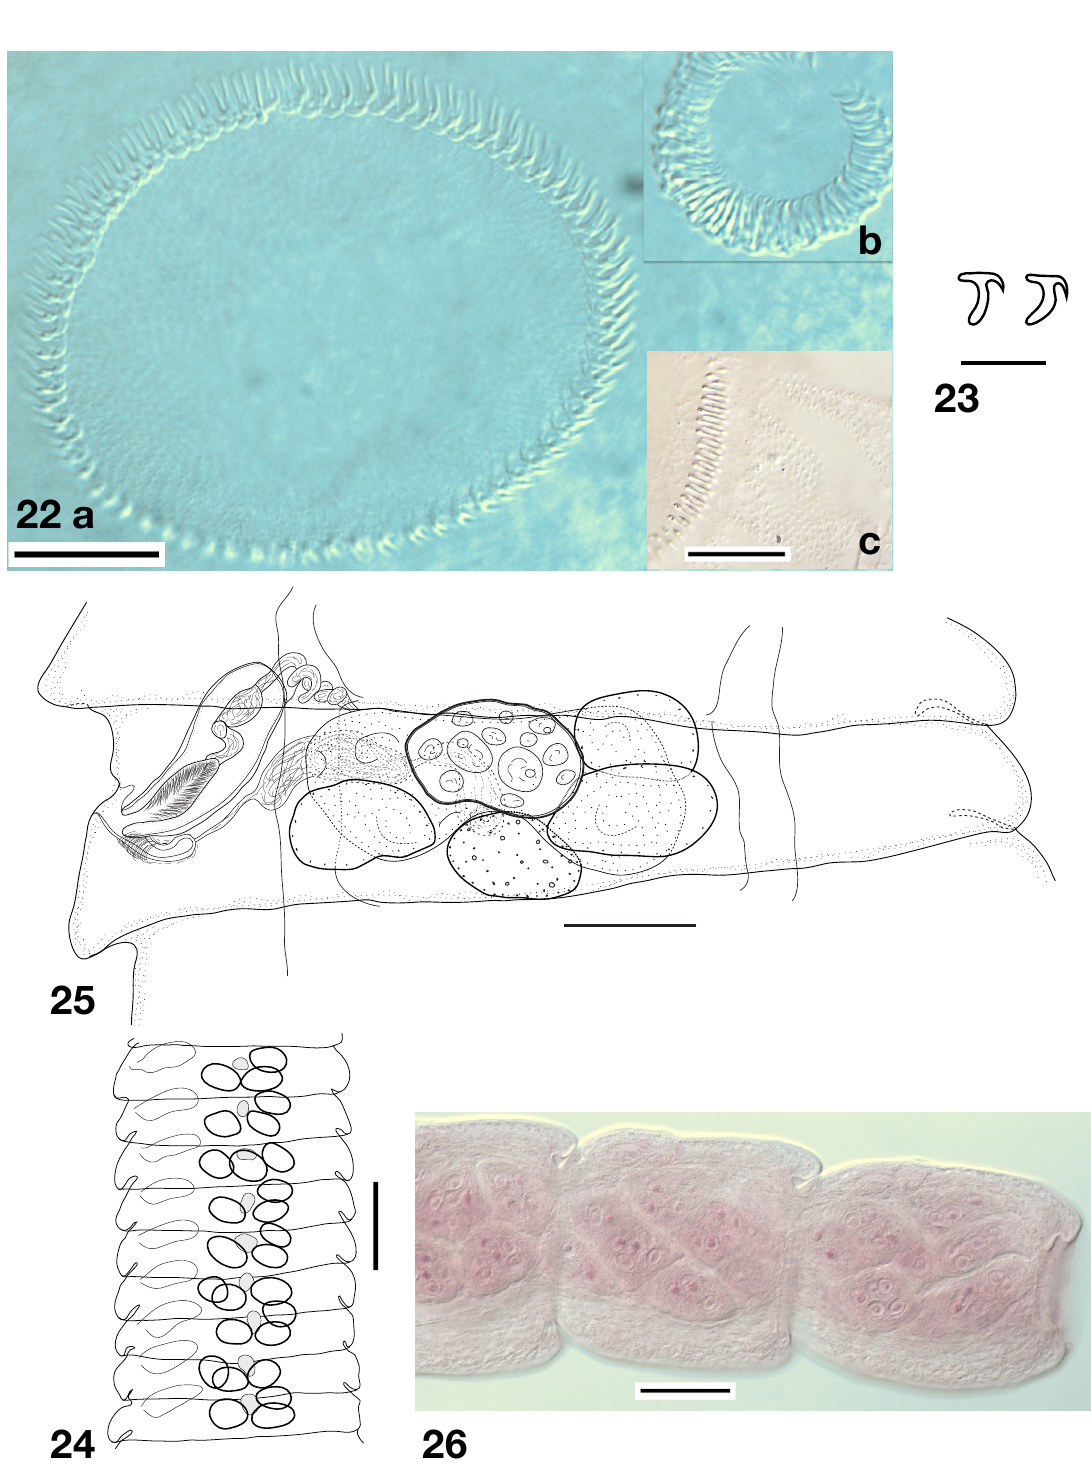
Figs 22-26. Raillietina hymenolepidoides sp. nov. 22 . a) Complete rostellar crown, b) Sucker's hooklets, c) Apical tegument with spiniform microtriches; 23 . Rostellar hooks; 24 . Sketch of male Figs 22–26. Raillietina hymenolepidoides sp. nov. 22 . a) Complete rostellar crown. b) Hooklets of sucker. proglottides showing relative position of testes; 25 . Early pregravid proglottide, dorsal view; 26 . c) Apical tegument with spiniform microtriches. 23 . Rostellar hooks. 24 . Sketch of male proglottides Gravid proglottides with developed capsules. Scale bars: 22 = 20 µm; 23 = 10 µm; 24, 26 = 100µm; showing relative position of testes. 25 . Early pregravid proglottis, dorsal view. 26 . Gravid proglottides 25 = 50 µm. with developed capsules. Scale bars: 22 = 20 µm; 23 = 10 µm; 24, 26 = 100 µm; 25 = 50